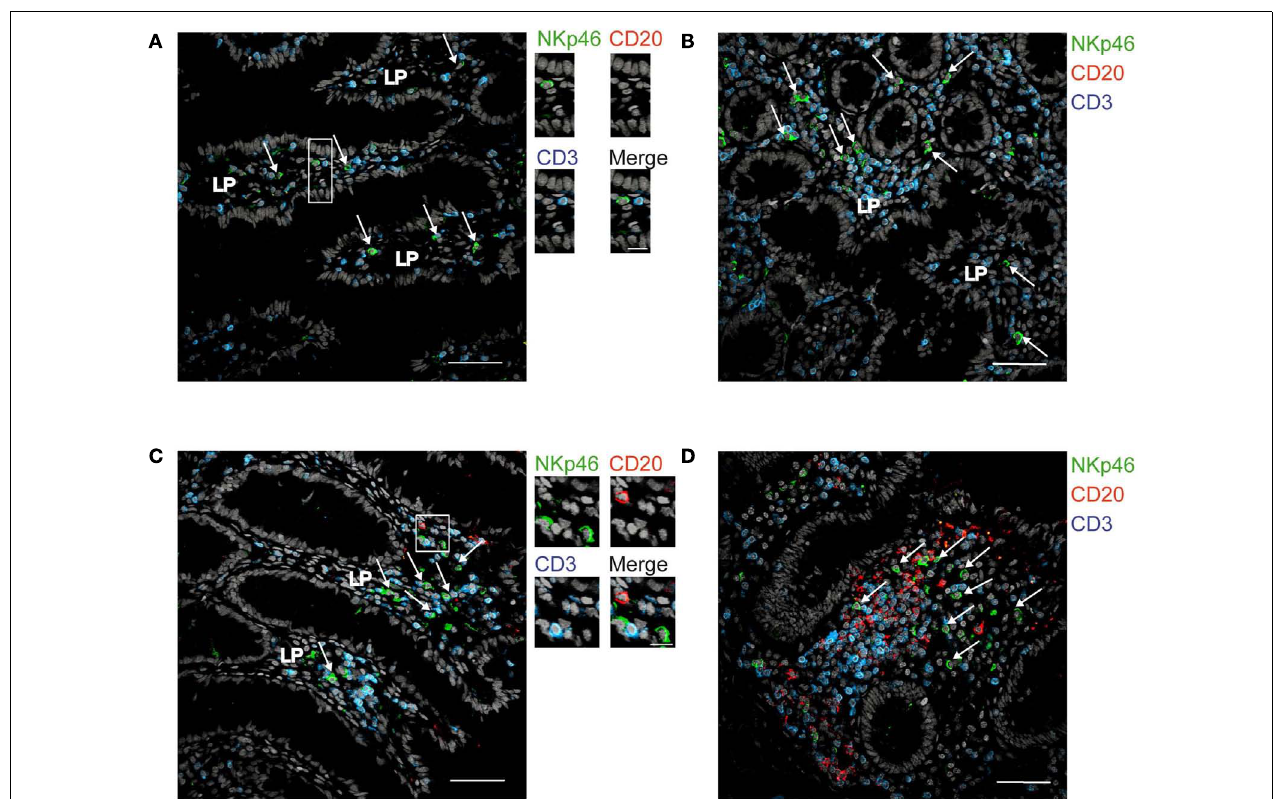
Nuclei were counterstained with Sytox (gray). Arrows indicate NKp46 + CD3 − cells. LP, lamina propria. Scale bar = 50 µ m. Data are representative of at least two independent experiments performed on three distinct individuals.